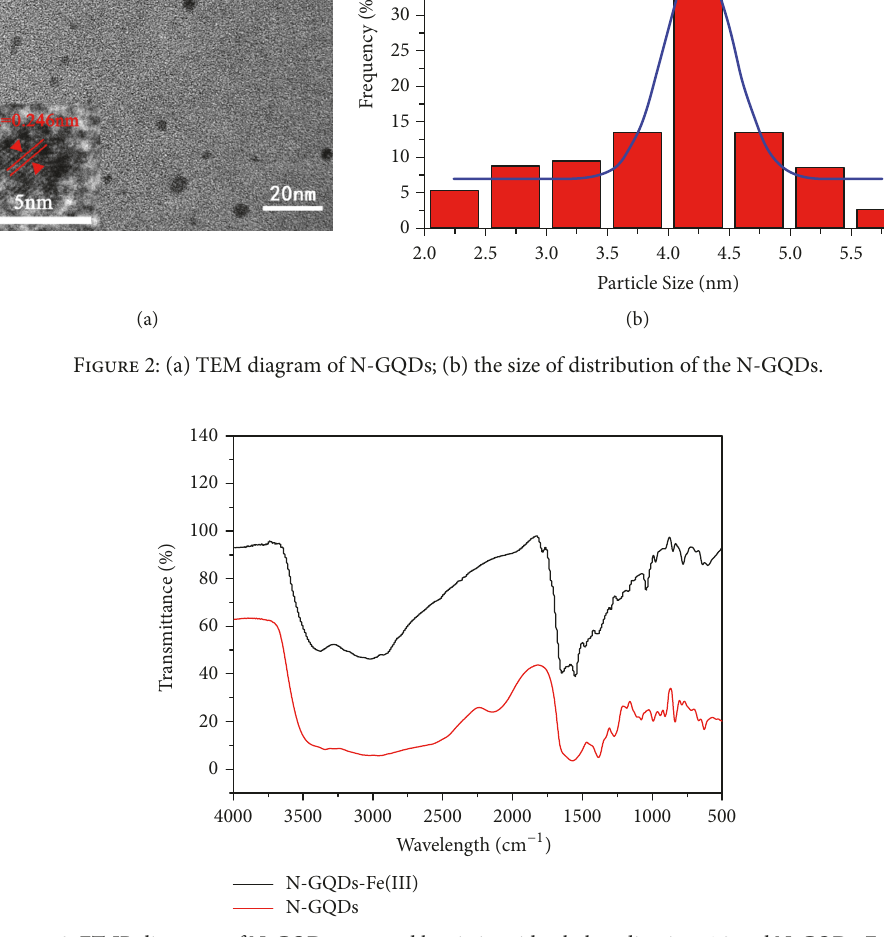
shape; the average size is less than 4.05nm and disperses uniformly in aqueous solution, without agglomeration. The typical lattice spacing is 0.290nm, which shows a graphitic structure of the as-obtained N-GQDs